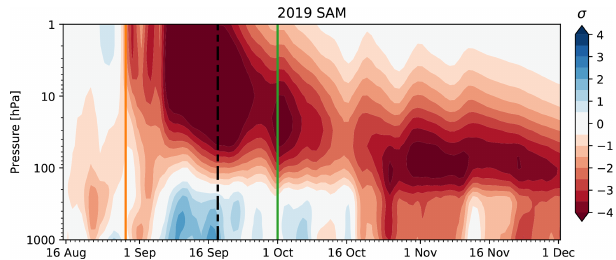
Figure 9. SAM indices during the September 2019 austral minor warming. The SAM indices are computed from ERA5 geopoten- tial height anomalies averaged over 65 to 90 ◦ S, analogously to the NAM indices shown in Figs. 5 and 7. The vertical dashed–dotted black line indicates the date of minimum zonal-mean zonal wind at 10hPa, 60 ◦ S. The vertical green and orange lines indicate the requested initialization dates.